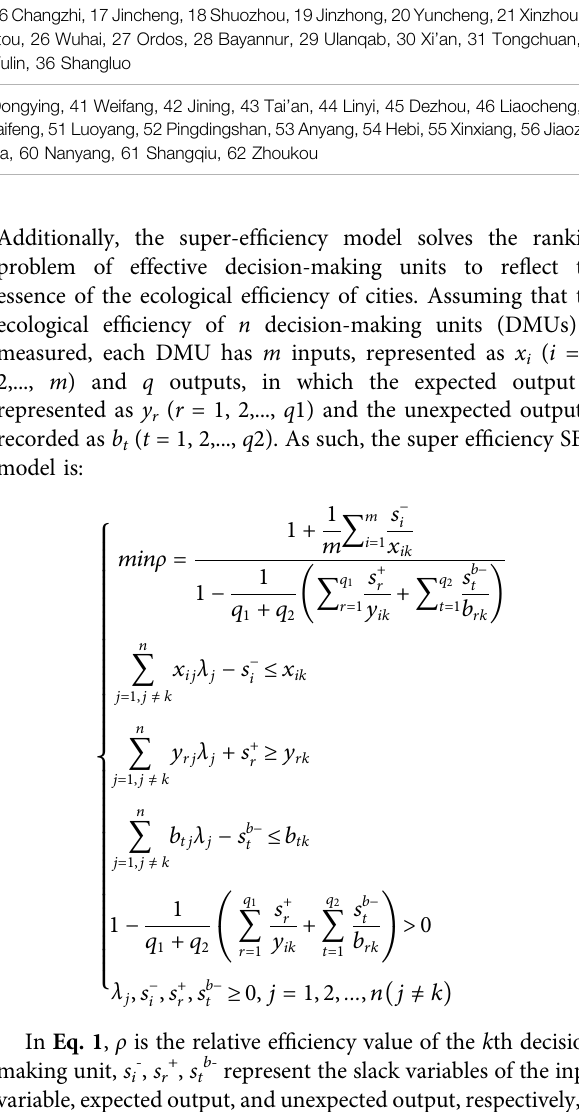
TABLE 1 | The division of cities in the upper, middle, and lower reaches of the Yellow River Basin. Region City